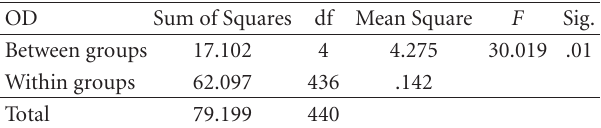
Table 8: Correlation between the human IgG responses against di ff erent HCF antigens using